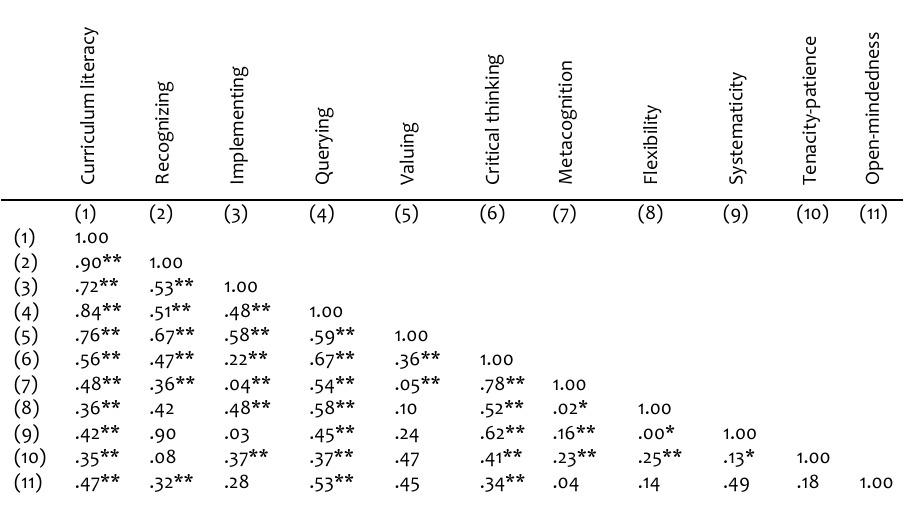
Table 3. Correlations between curriculum literacy and critical thinking